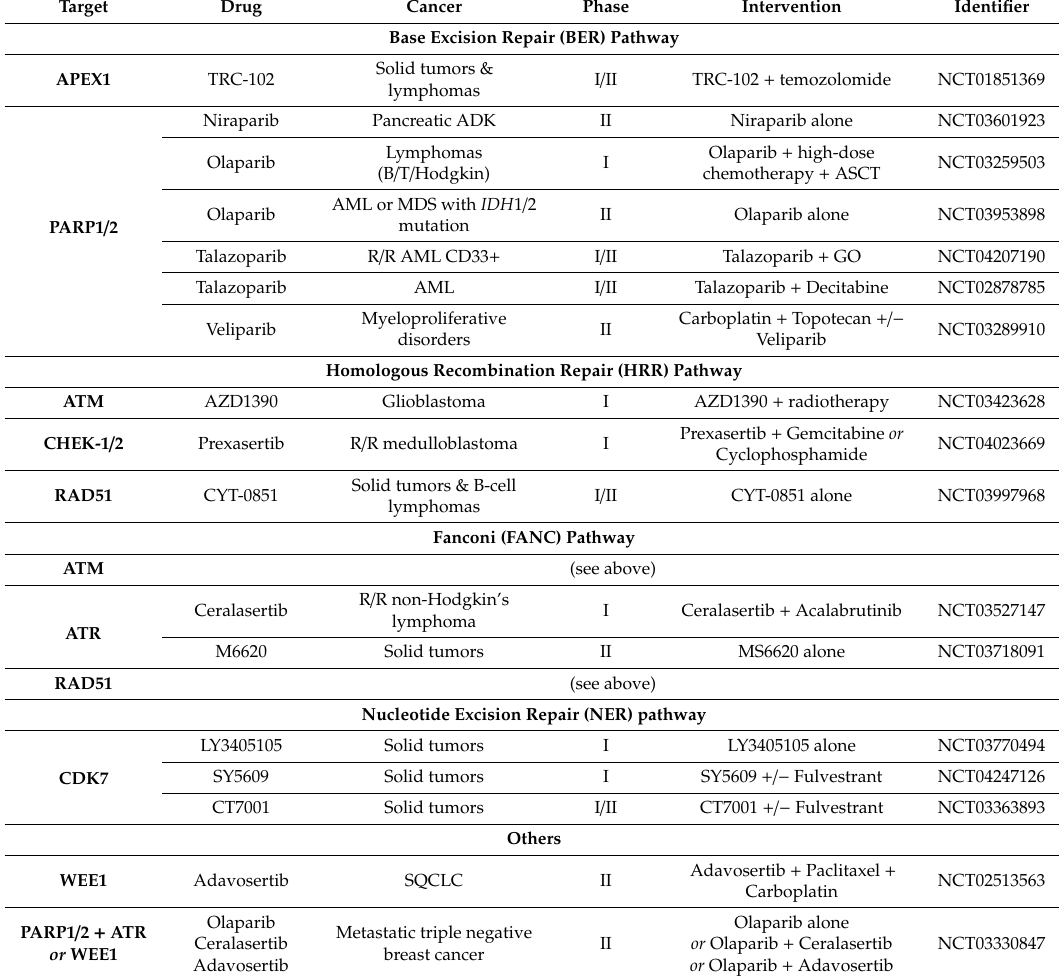
Table 5. A non-exhaustive list of recruiting clinical trials for DNA repair targeting drugs in 2020 (www.clinicaltrials.gov). ADK: adenocarcinoma. AML: acute myeloid leukemia. ASCT: autologous stem cell transplant. GO: gemtuzumab ozogamicin. MDS: myelodysplastic syndrome. R / R: relapsed or refractory. SQCLC: squamous cell lung